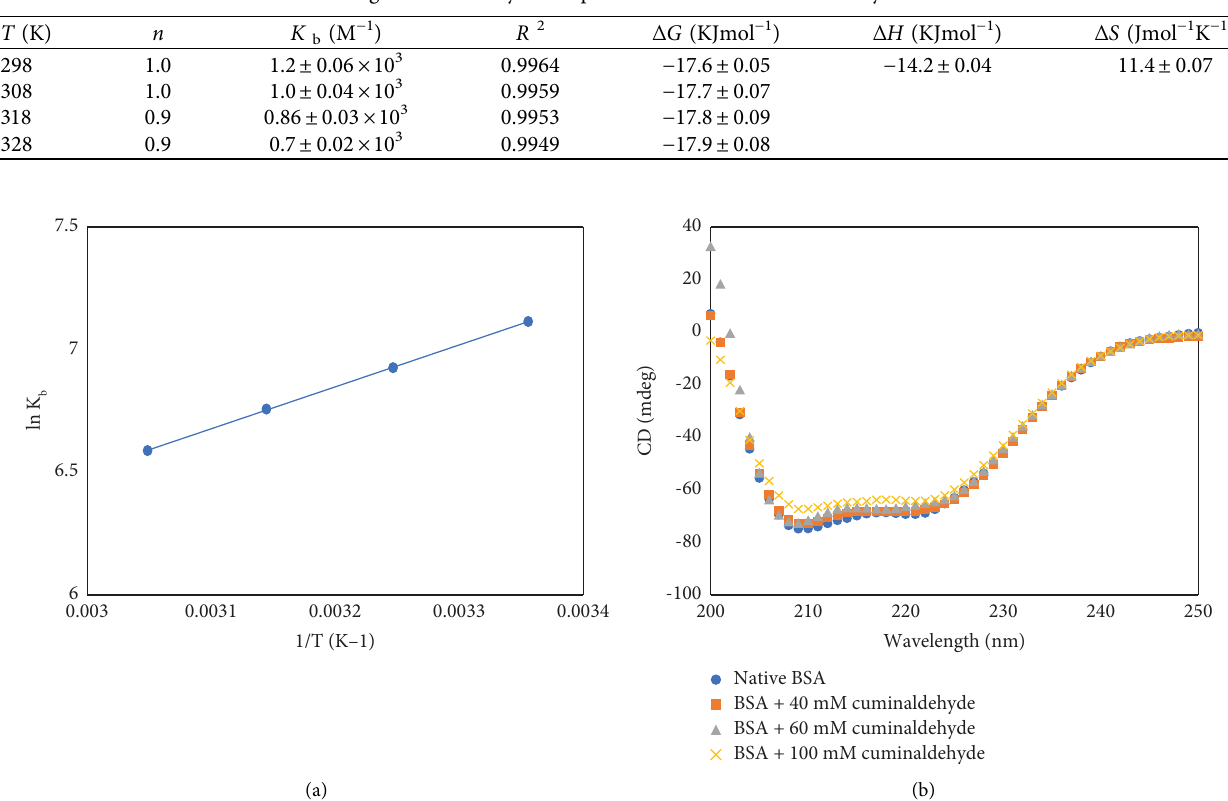
Table 3: Binding and thermodynamic parameters of BSA–cuminaldehyde